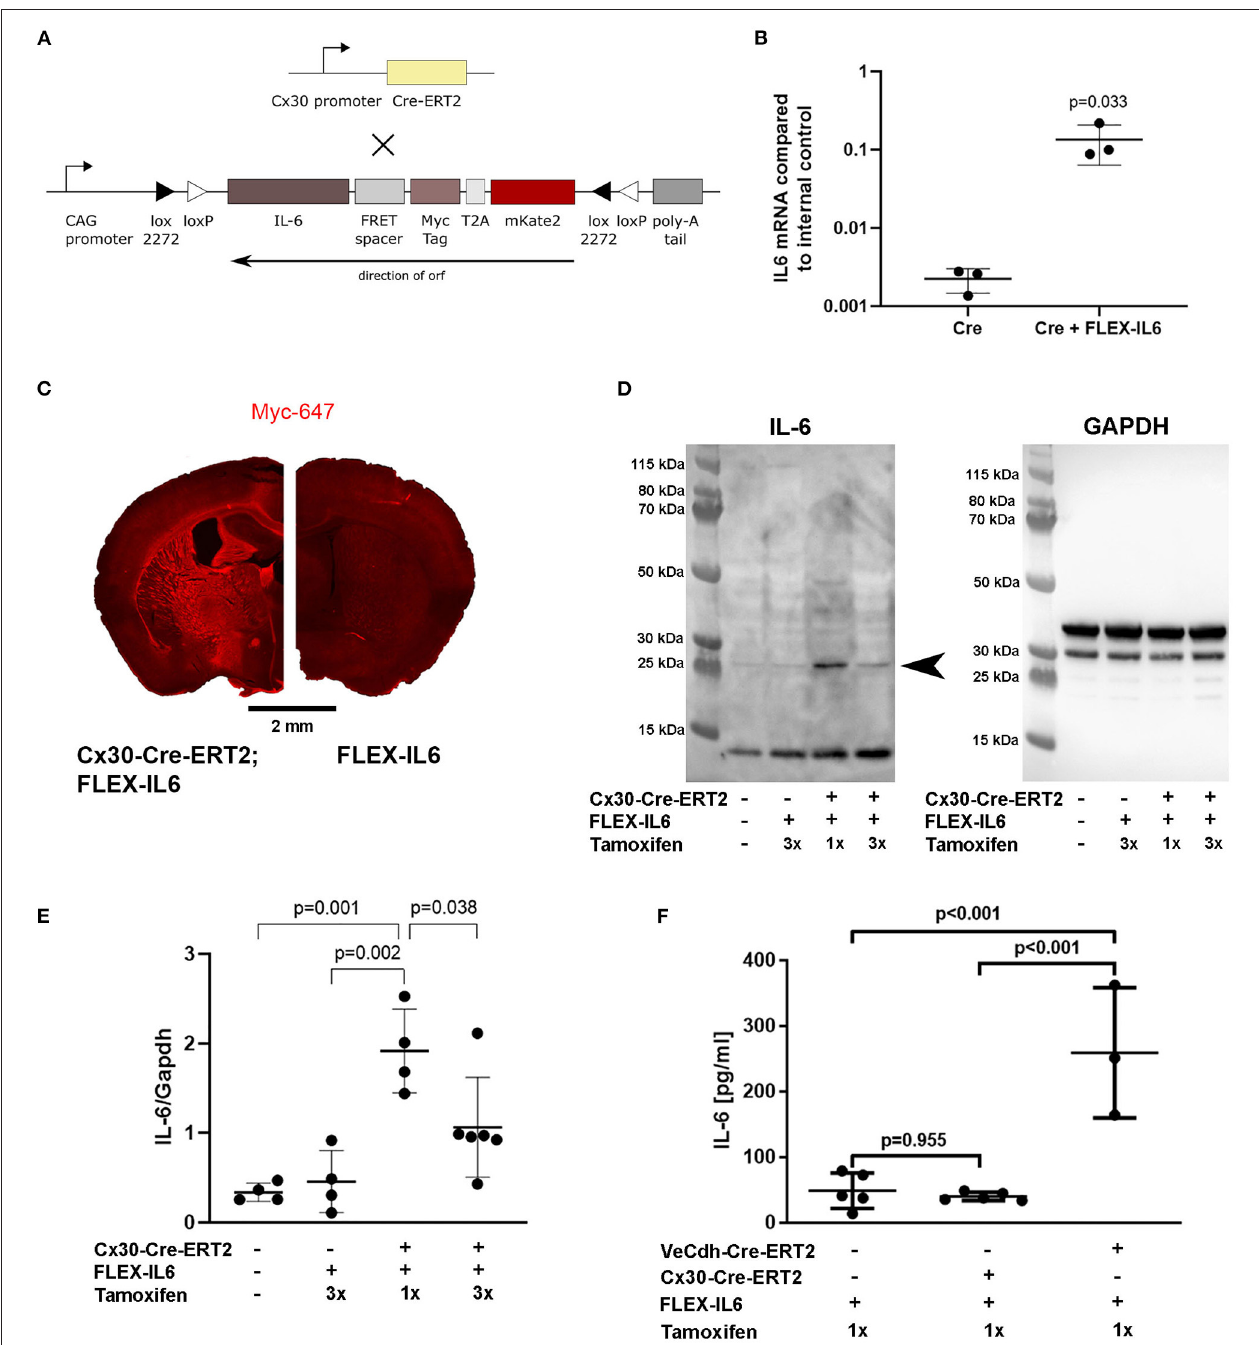
FIGURE 1 | Development of the Cx30-Cre-ERT2;FLEX-IL6 mouse model for brain-specific IL-6 expression. (A) Design of the custom-made mouse line for inducible and traceable secretion of IL-6 (FLEX-IL6). The murine Il6 sequence is linked to a myc-tag followed by the self-cleavage site T2A and mKate2. This construct is inverted and embedded in a flip and excision (FLEX) cassette in the silent R26 locus. To enable paracrine cerebral IL-6 secretion, we crossbred FLEX-IL6 mice with the astrocyte-specific inducible Cre-driver mouse line Cx30-Cre-ERT2. Upon tamoxifen administration, active Cre flips and excises one recombination site and thus permanently induces Il6 expression in astrocytes. (B) Endothelial bEnd.3 were incubated for 1h with conditioned cell culture supernatants of HEK cells transfected with Cre and the FLEX-IL6 construct or Cre only as negative control and Il6 mRNA was determined by real-time RT-PCR. Ectopic IL-6 increases bEnd.3 IL-6 expression by almost 100x. n = 3 independent experiments. (C) Representative Myc-tag staining after tamoxifen administration. Upon induction with tamoxifen, myc-IL-6 is widely expressed in Cx30-CRE-ERT2;FLEX-IL6 mice, while there is no induction in FLEX-IL6 control mice. (D,E) Cerebral IL-6 protein levels were determined by immunoblot analysis of brain homogenates of Cx30-Cre-ERT2;FLEX-IL6 mice receiving one mg tamoxifen for 1 or 3 days from n = 4–6 mice per group as displayed in the scatter